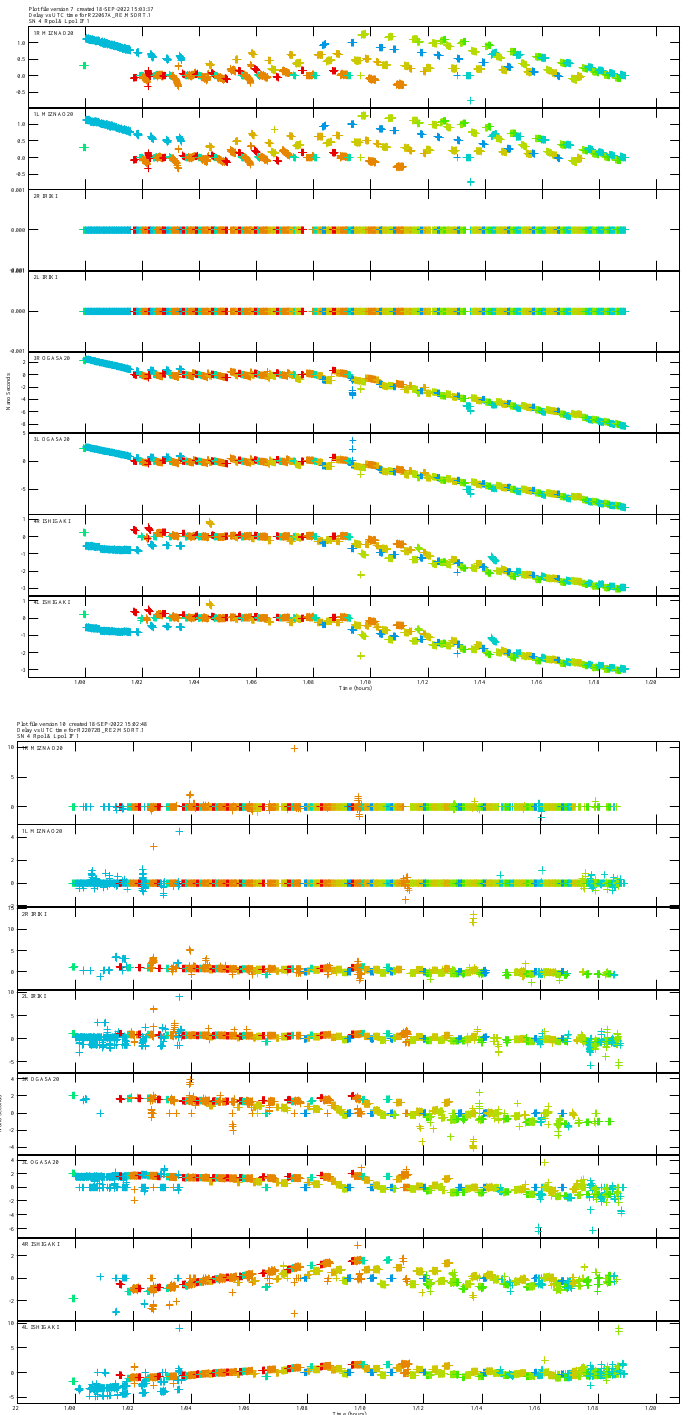
Figure 4. Plots of the delay solutions obtained at 22 GHz ( upper ) and 43 GHz ( lower ), with each point being indicated in different colors that correspond to different sources. Units of vertical and horizontal axes are in nanoseconds and hours,